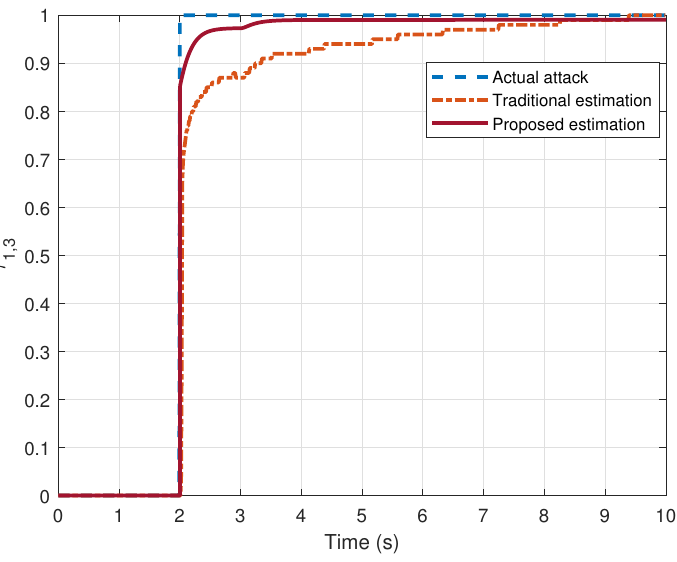
Figure 9. Delay estimation using the proposed method compared with the traditional